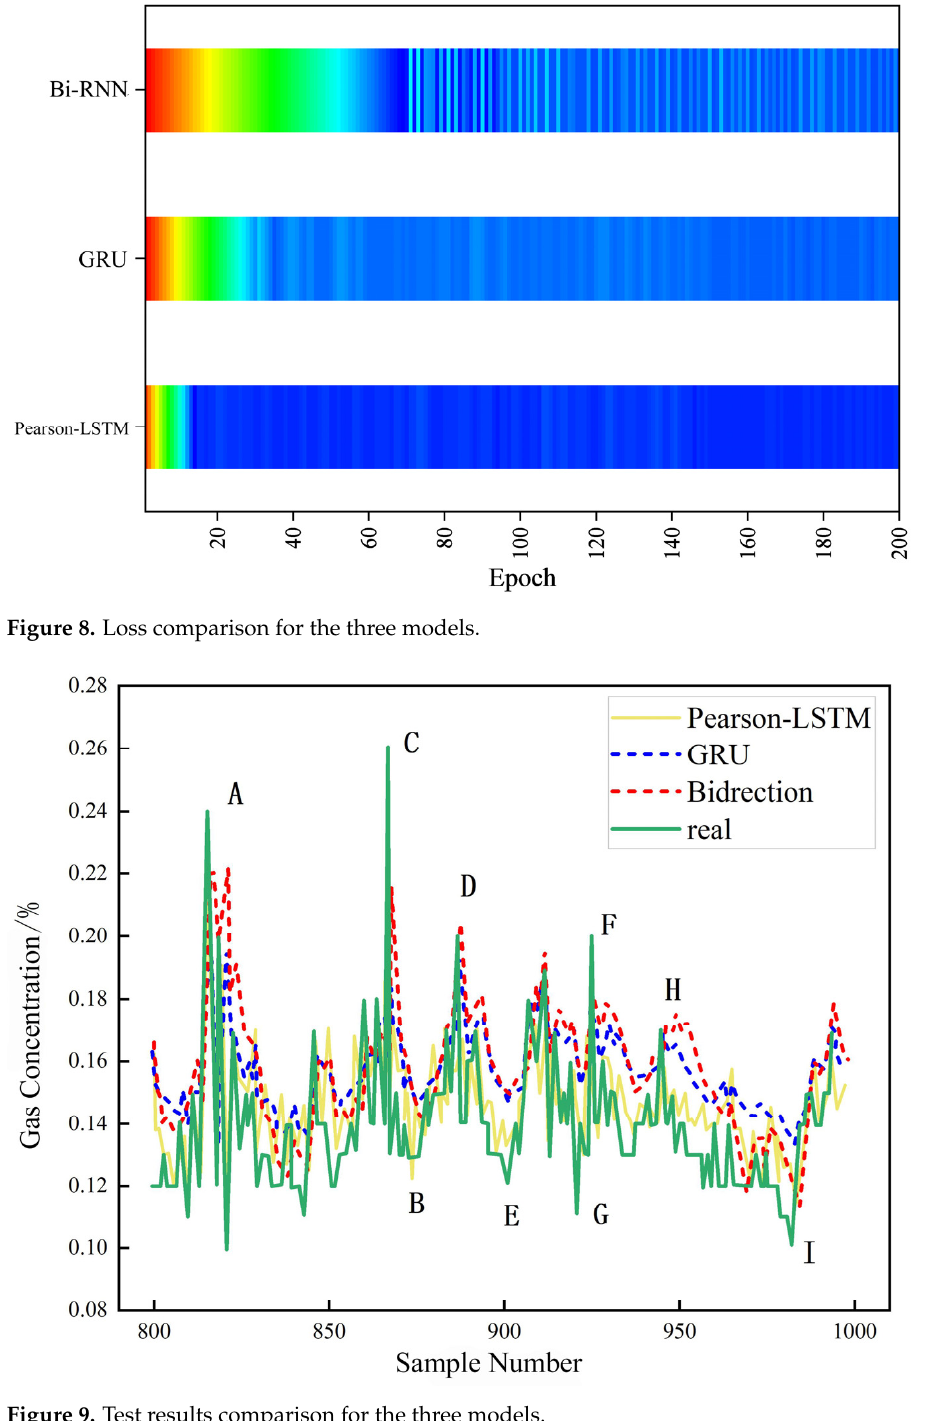
Table 5. Comparison of prediction results.